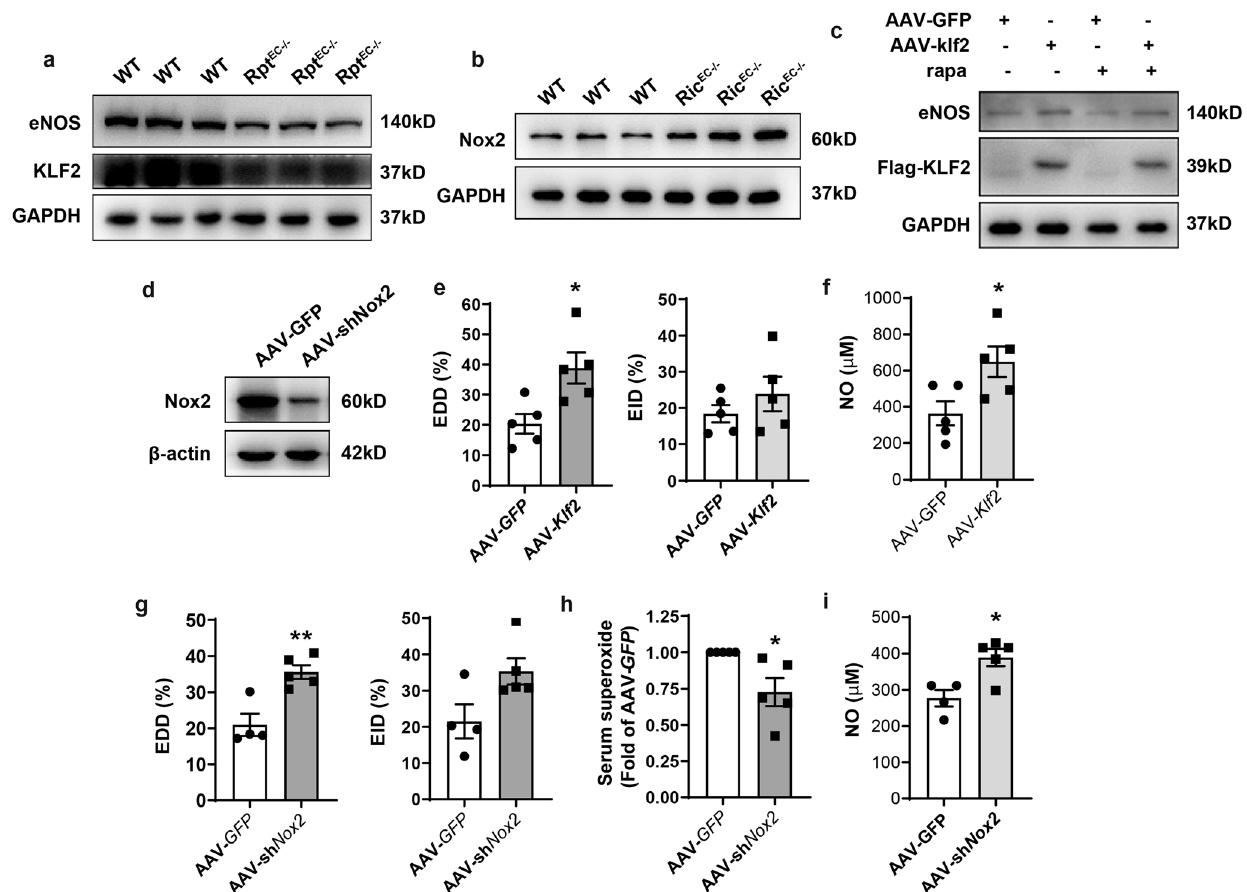
Fig. 7 Modulation of KLF2 or Nox2 expression restored EDD function in endothelial mTORC1- or mTORC2-inhibited mice. a , b EC were isolated from Rptor EC − / − or Rictor EC − / − and their WT littermates followed by western blotting. c EC isolated from wild-type mice were infected with empty AAV (AAV- GFP) or Klf2 -expressing adeno-associated virus (AAV- Klf2 ) at a multiplicity of infection (MOI) of 10 5 vg/cell for 72 h, then treated with or without 1 nM rapa for 1 h followed by western blot analysis. d Murine EC was infected with AAV containing two tandem mouse Nox2-targeting sequences (AAV- sh Nox2 ) followed by western blot analysis. e , f Rptor EC − / − mice were i.v. injected with AAV-GFP or AAV- Klf 2 at 3 × 10 11 vg. EDD and EID were evaluated with transcutaneous ultrasound imaging ( n = 5, e ), and serum NO evaluated by the colorimetric measurement ( n = 5, f ). g – i , Rictor EC − / − mice were injected with 3 × 10 11 vg AAV-GFP or AAV-sh Nox2 followed by evaluation of EDD and EID ( n = 5, g), and evaluation of serum superoxide ( n = 5, h ) and NO by the colorimetric measurement ( n = 4, i ). Error bars correspond to the standard error of the mean (SEM). * p < 0.05; ** p < 0.01 vs. AAV-GFP; unpaired two-tailed t test ( e – g , i ) or one sample t test ( h